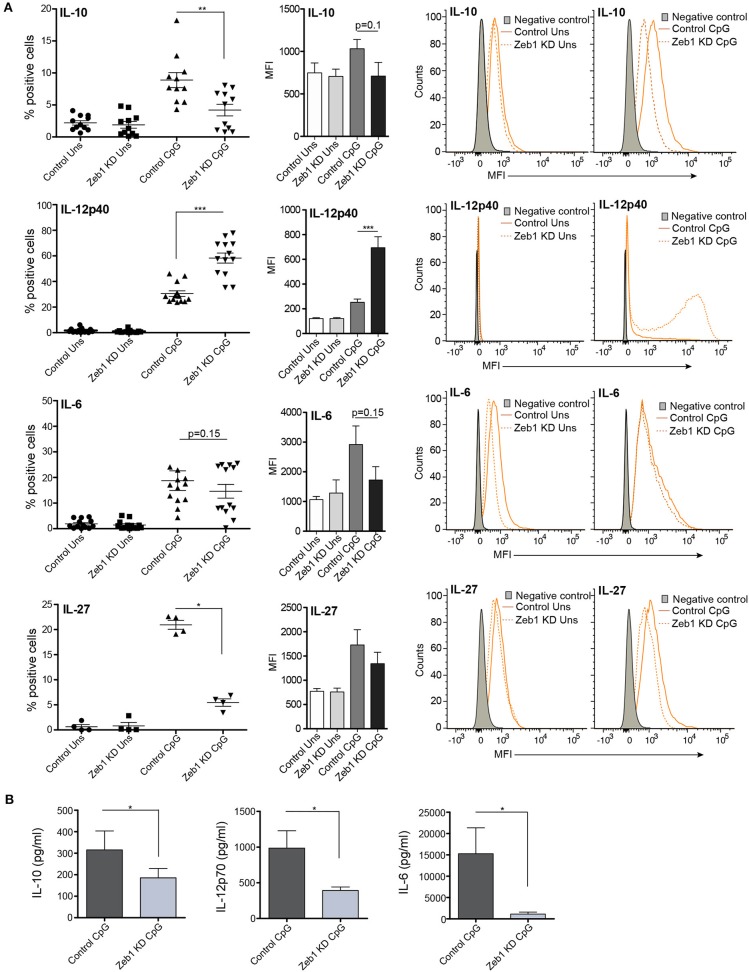
EMT factor Zeb1 KD suppresses expression of important DC response cytokines in cDC1 MutuDCs. (A) Scatter-plots showing the percentage positive cells for intracellular cytokines IL-10, IL-12p40, IL-6, and IL-27 in Zeb1 KD cDC1 MutuDCs compared to control cells before and after 12 h CpG activation. The corresponding bar plots and representative histograms in each panel depicting the MFI shifts for these cytokines in Zeb1 KD as compared to control DCs n = 8–12. (B) Bar-plots demonstrating the Bio-plex based quantitation of IL-10, IL-12p70, and IL-6 cytokines secreted in the supernatants of 12 h CpG activated Zeb1 KD and control DCs n = 5. p-values are calculated using two tailed unpaired student's t-test, error bars represent SEM. * ≤ 0.05, ** ≤ 0.01, *** ≤ 0.001.